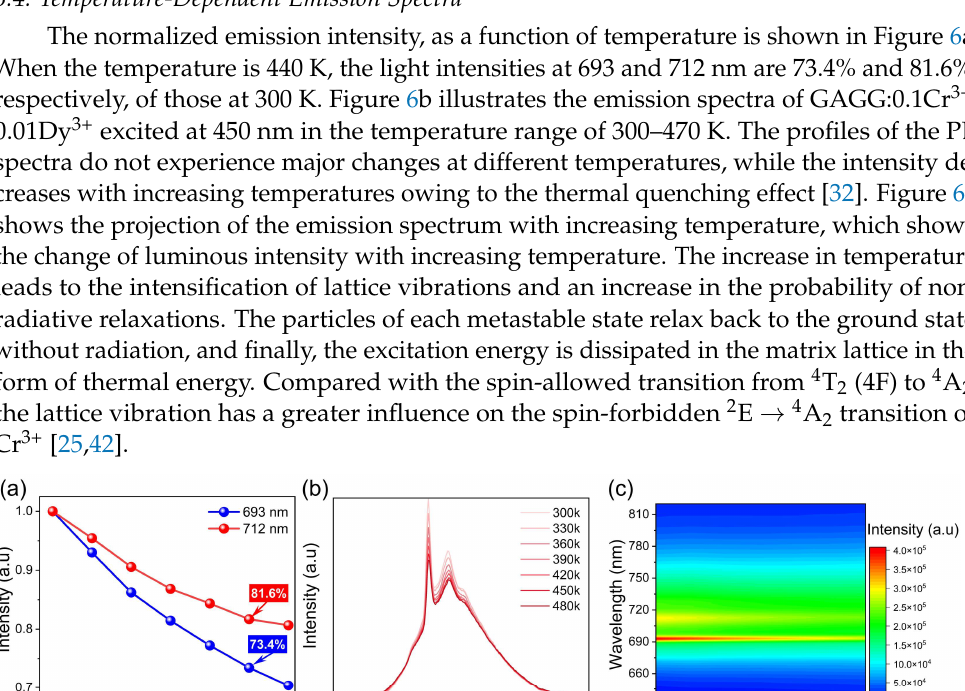
Figure 5. ( a ) Decay curves of Dy 3+ emission in GAGG: x Cr 3+ , 0.01Dy 3+ ; ( b ) energy levels, electron transitions and energy transfer schematic diagram of Dy 3+ and Cr 3+ in GAGG.